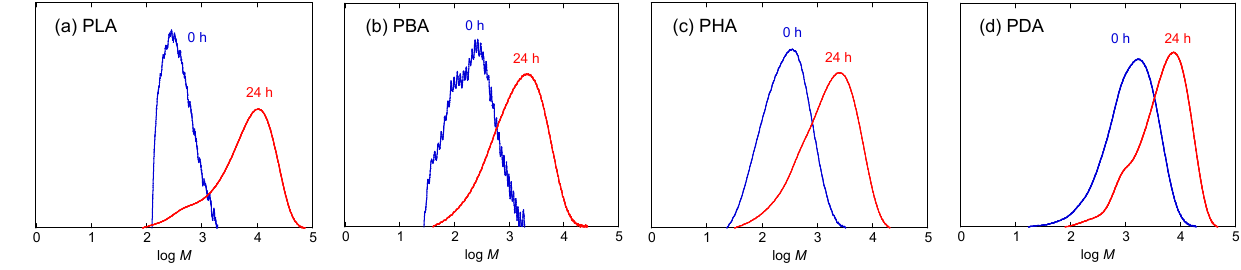
), molecular weight distribution ( M n